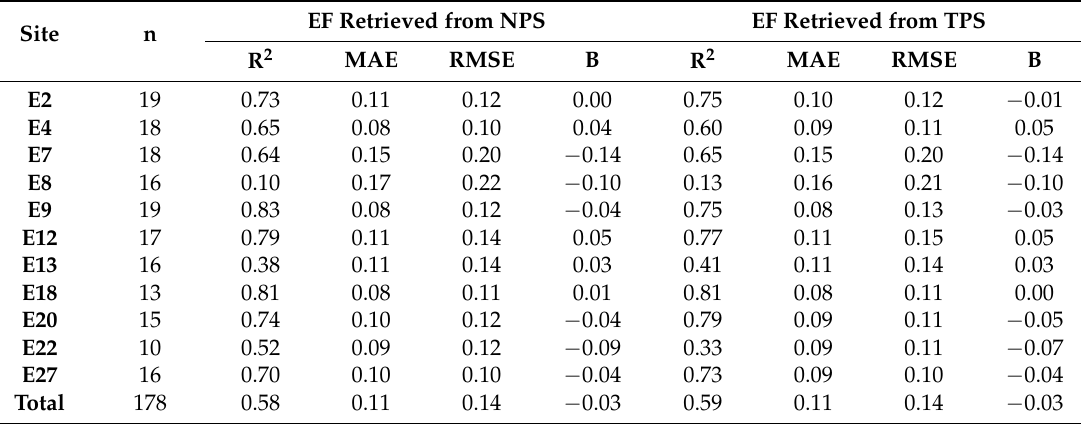
Figure 5. Comparison between observed EF and estimated EF generated by the TPS ( a ) and the NPS ( b ). Table 4. Accuracy of EF retrieved from TPS and NPS for all the sites.